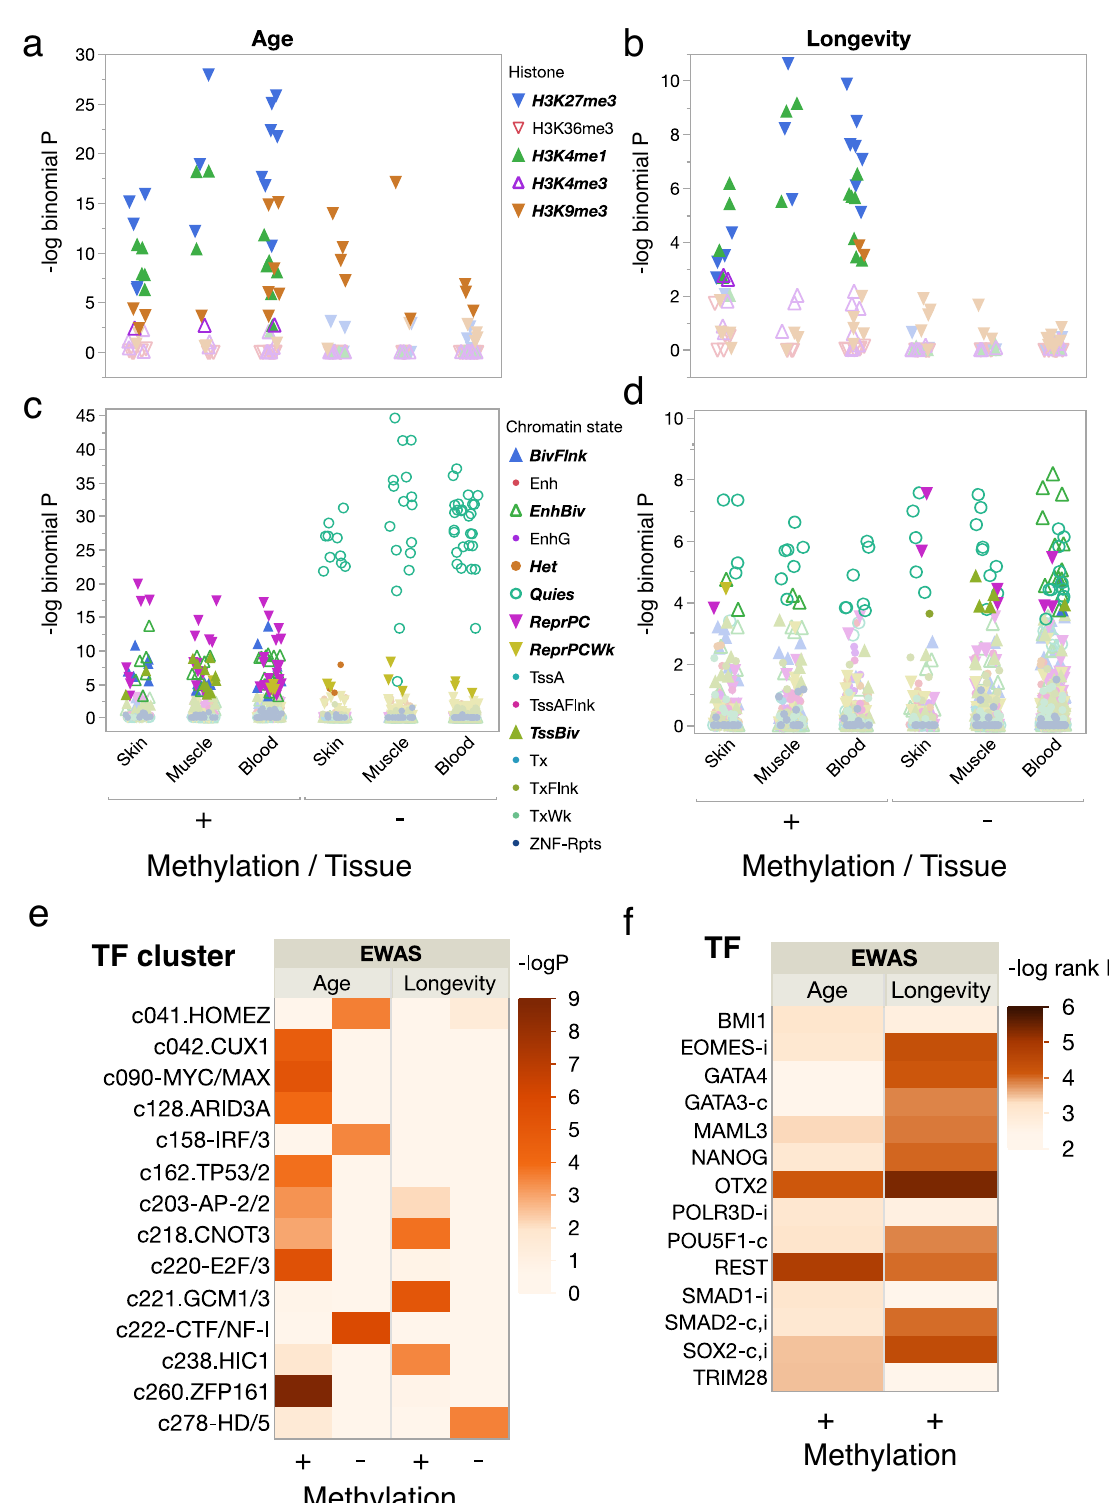
using all samples from several species in the same genus. The second type consisted of leaving out a single species (LOSO) from the regression, thereby predicting the age of each sample using the data for all other species. Differentially methylated positions (DMPs) for age and longevity . To identify DMPs associated with age, we used WGCNA and METAL to compute the Pearson correlation coef fi cient between methylation level ( β ) and chronological age for